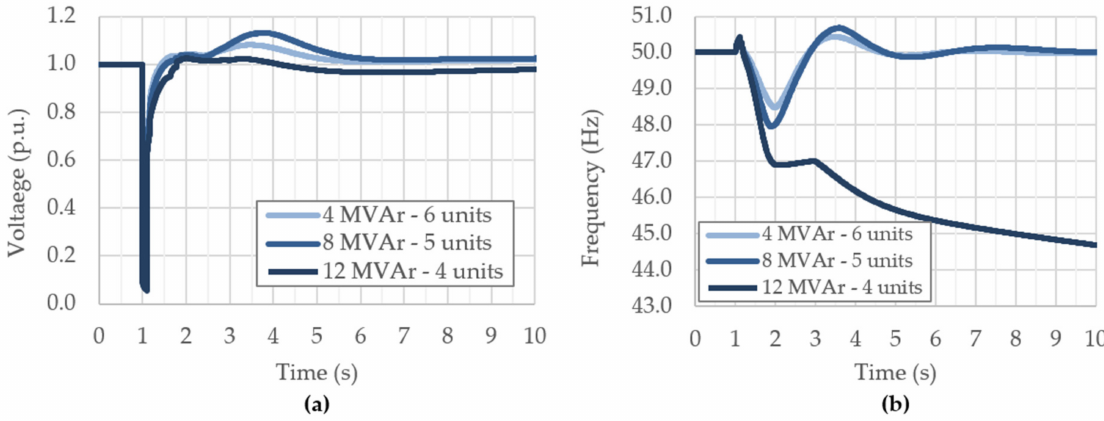
Figure 14. HV bus voltage ( a ) and frequency ( b ) at Soroni TPP—loss of S. Rhodes